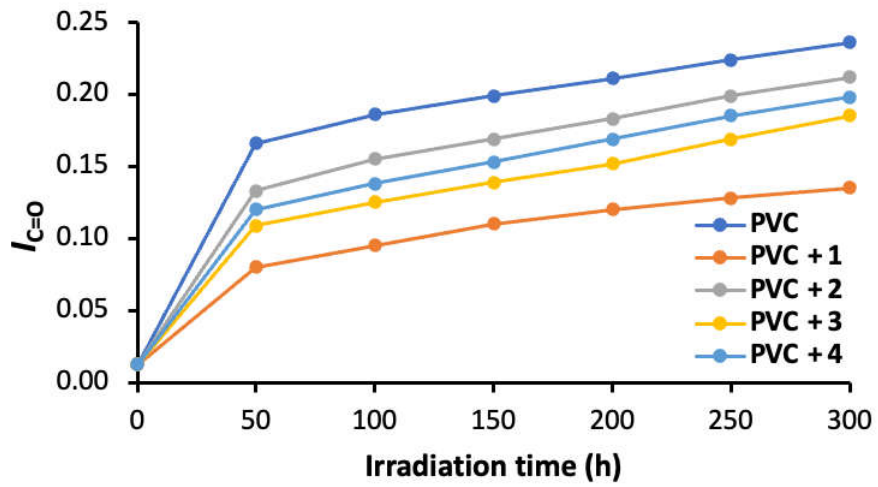
Figure 3. A plot showing the evolution of the I C=O for PVC films as a function of irradiation time.